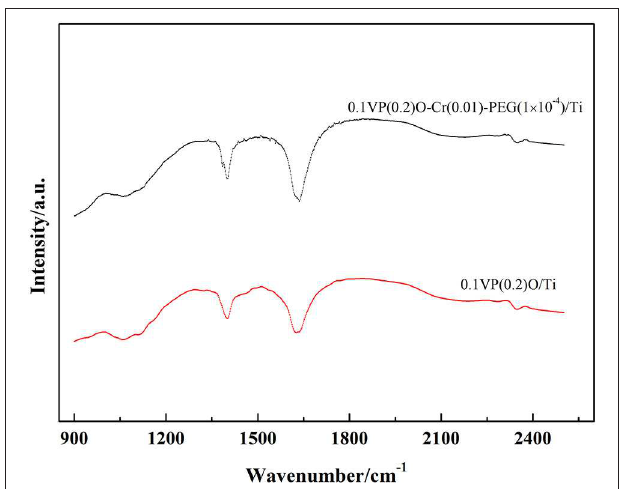
FIGURE 12 | NH 3 -IR spectra of catalysts.